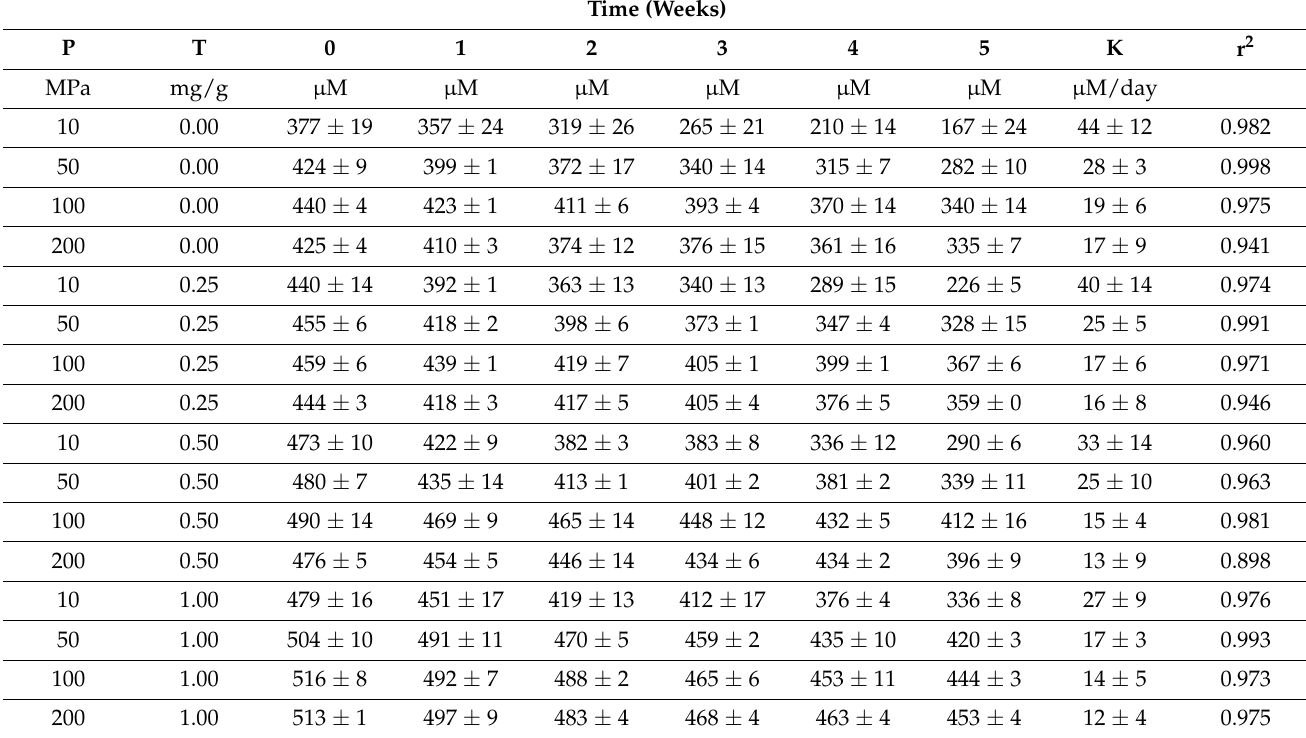
Table 1. Three-way analysis of variance using pressure, amount of α -tocopherol, and storage time as factors. P is the microfluidizer pressure (MPa). T is the amount of α -tocopherol per g of emulsion (mg/g). The results express the concentration of vitamin A ( µ M) during five weeks of storage. The average precision of the results is 1%. The rate constant (k) is calculated as the best fit of a zero-order rate law and expressed as average ± standard deviation. The coefficient of determination is reported as r 2 .